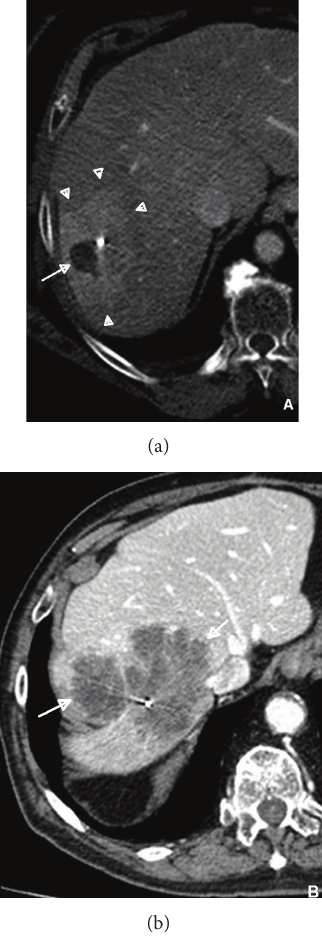
Figure 8: Two patterns of response in the surrounding liver parenchyma following treatment of metastases, the most prevalent being hyperdense halo (a) and isodense to the rest of the liver (b). Arrows point to the treated lesion and arrowheads to the response of the surrounding